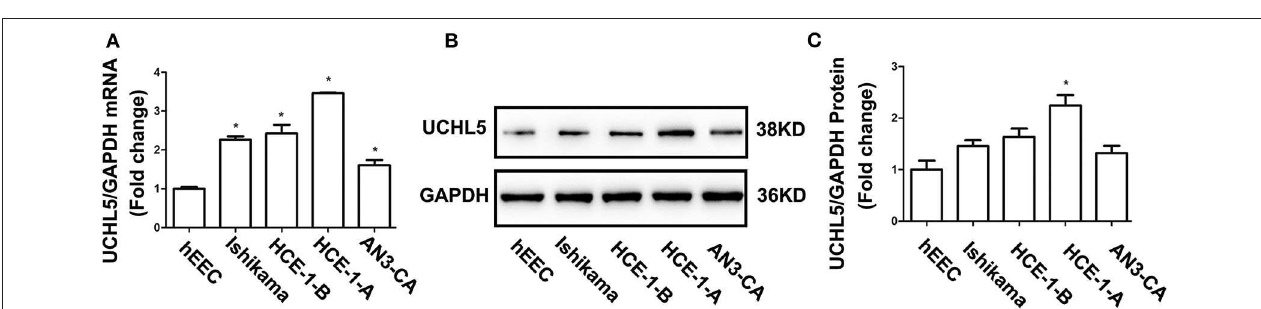
FIGURE 2 | UCHL5 expressed in different endometrial cancer cell lines. (A) Relative mRNA levels of UCHL5 measured by qRT-PCR in human endometrial epithelial cell hEEC and four endometrial cancer cells (Ishikawa, HCE-1-B, HCE-1-A, AN3-CA) ( N = 3). * P < 0.05 vs. hEEC. (B) Representative bands of UCHL5 and GAPDH in tumors were evaluated by western blot. (C) Statistical diagram of protein levels of UCHL5 ( N = 3 times). * P < 0.05 vs.